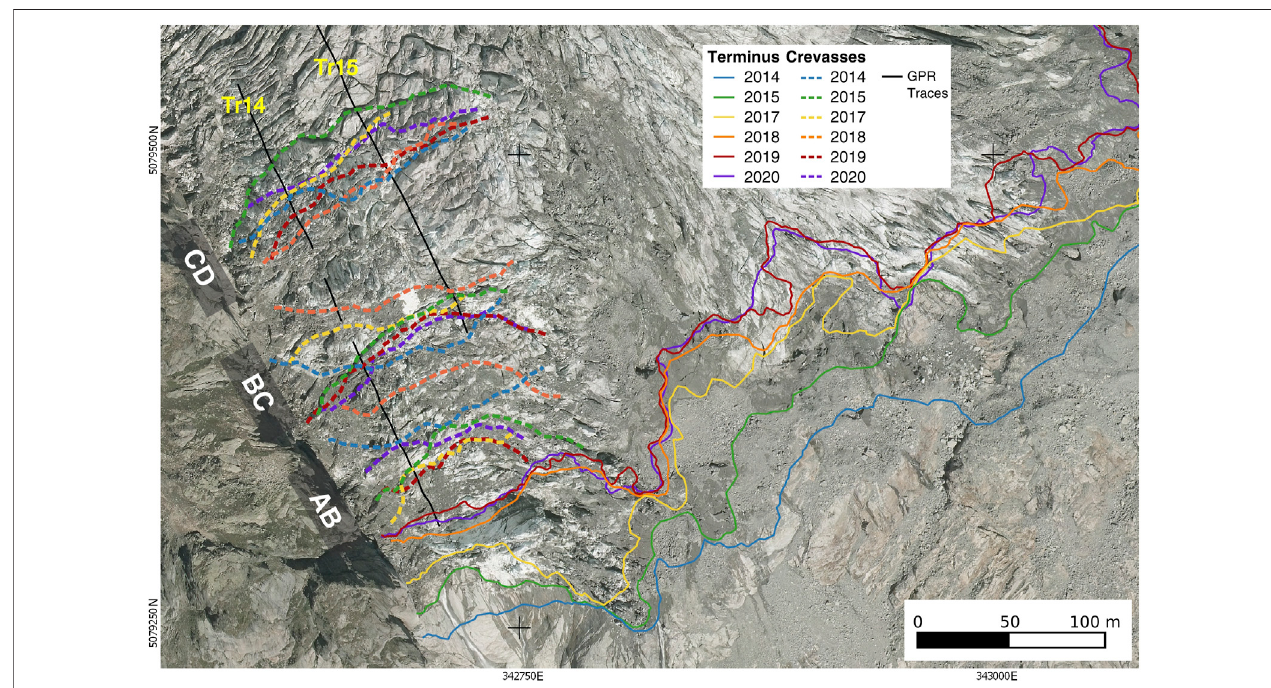
FIGURE5| Positionsofthemajorcrevassesandterminisince2014areindicatedbydashedandsolidcoloredlines,respectively.ThesolidblacklinereferstoGPR pro fi les n. 14 and 15. The grey boxes showed the locations of the sectors ’ limits.